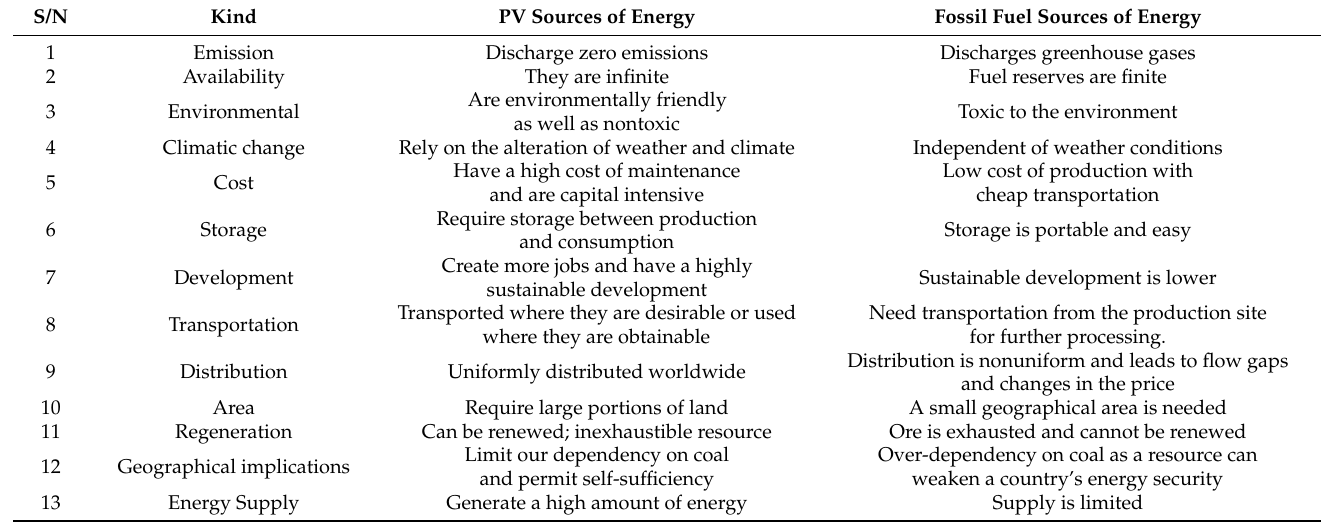
Table 1. Comparative advantages of PV energy to resources from fossil fuel